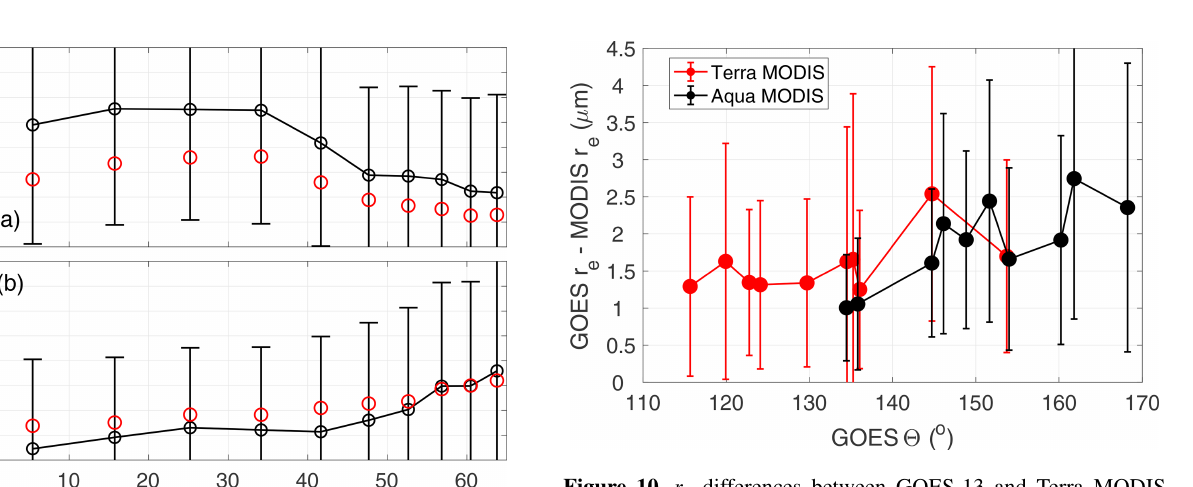
Figure 8. As Fig. 7 but for GOES-13 and Aqua MODIS.